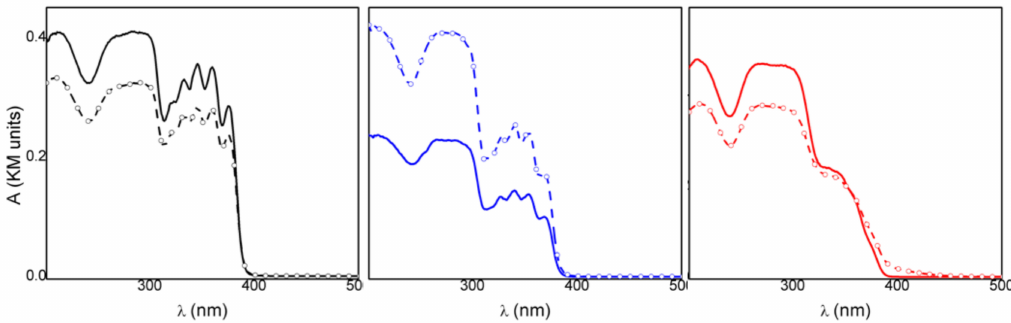
Figure 4. Absorption spectra of KETH (black line), KET-Na (blue line), and ZnAl-HTlc-KET (red line) before and after 120 (cid:48) irradiation at 330